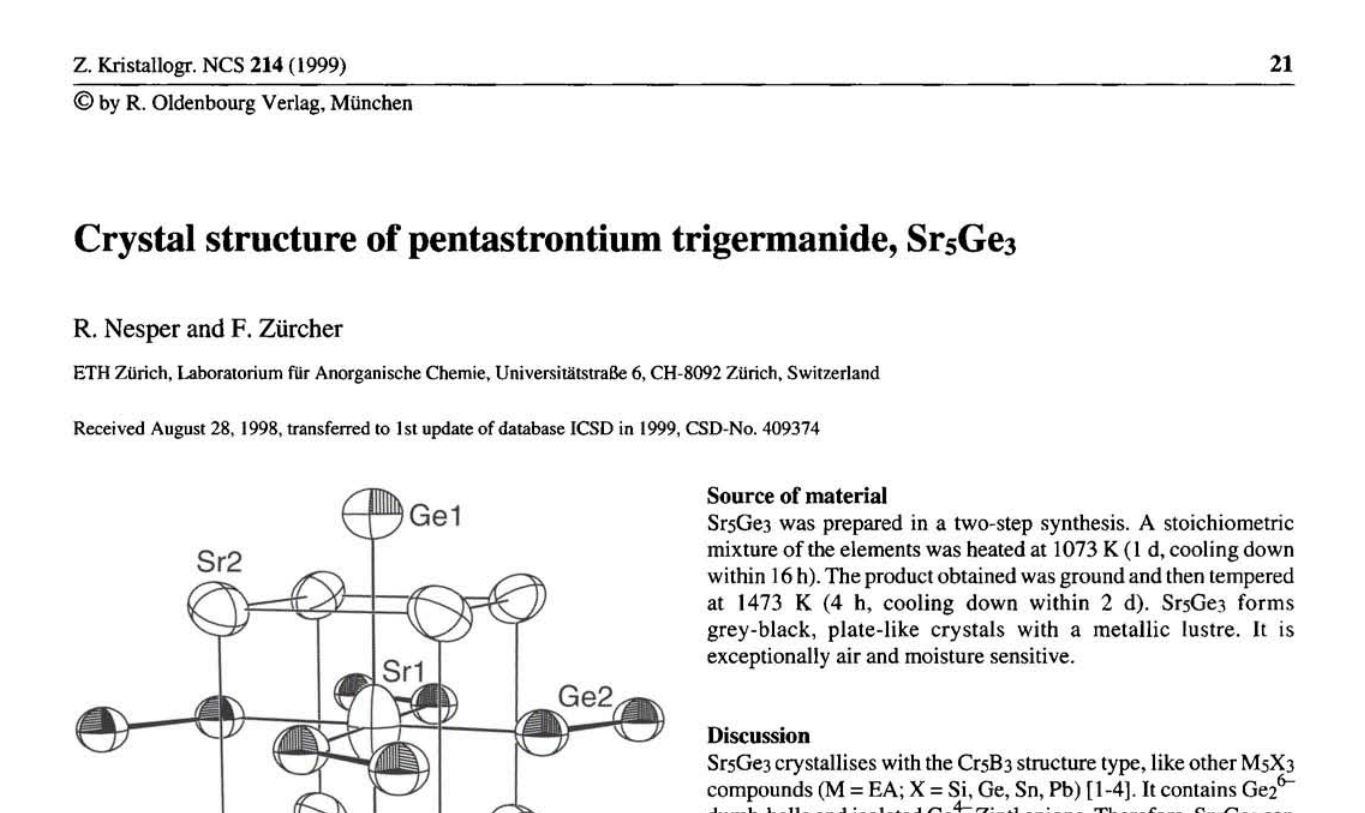
Table 1. Data collection and handling.